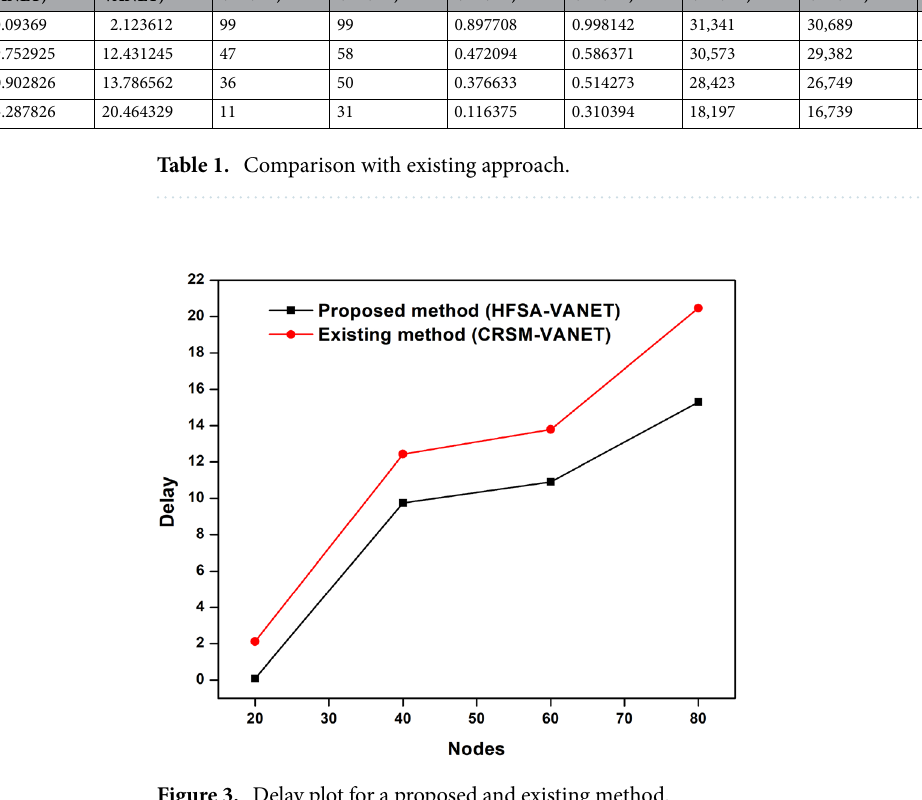
Figure 3. Delay plot for a proposed and existing method.